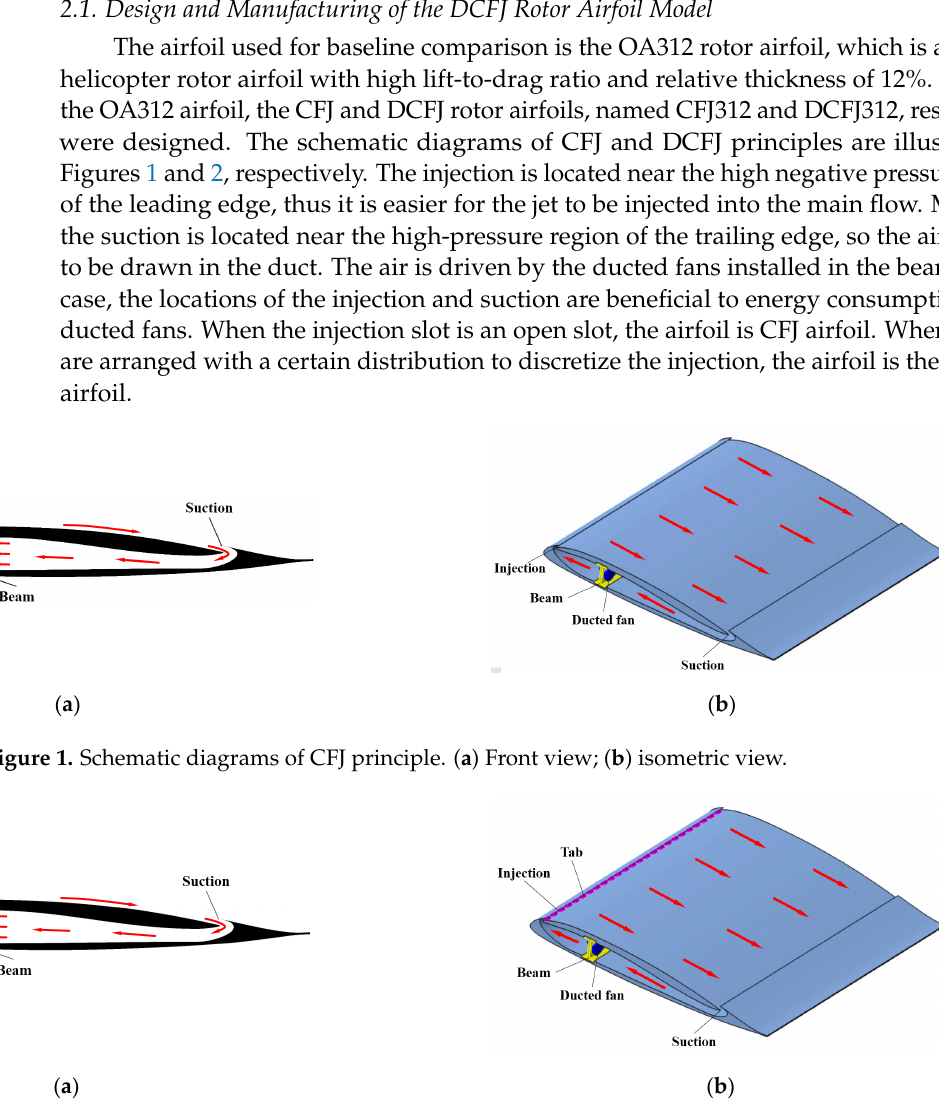
Figure 2. Schematic diagrams of DCFJ principle. ( a ) Front view; ( b ) isometric view.